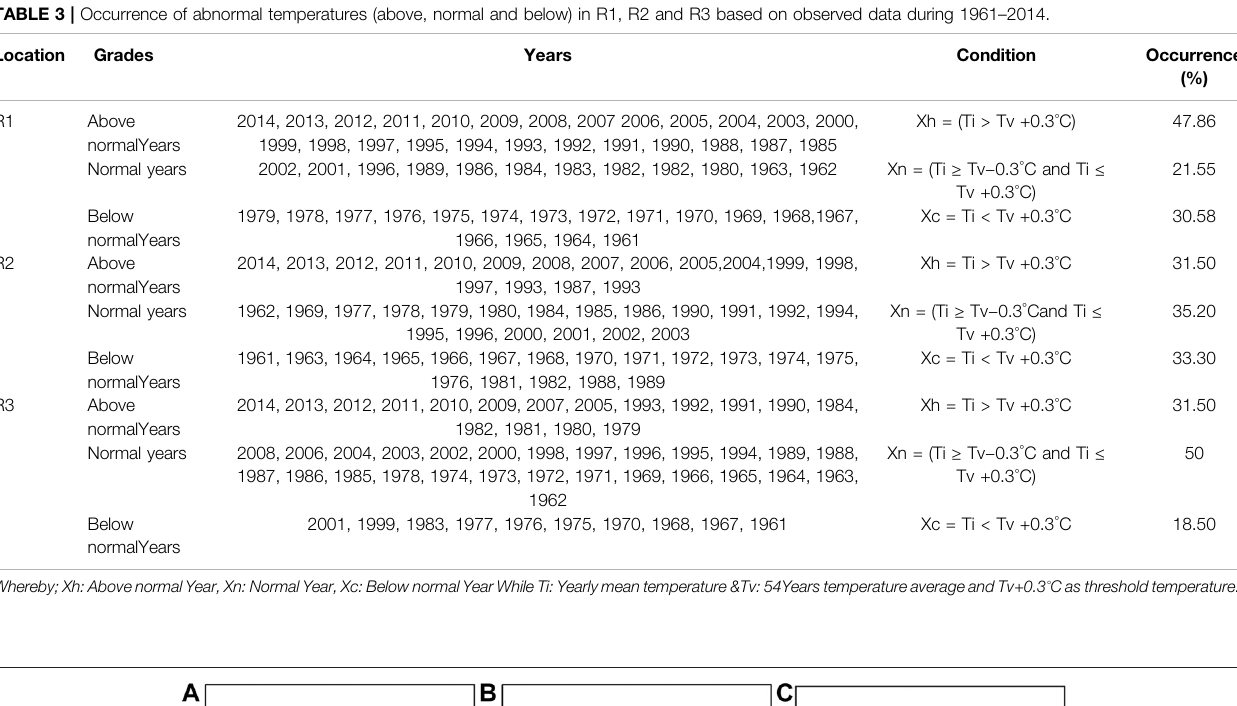
Frontiers in Earth Science |